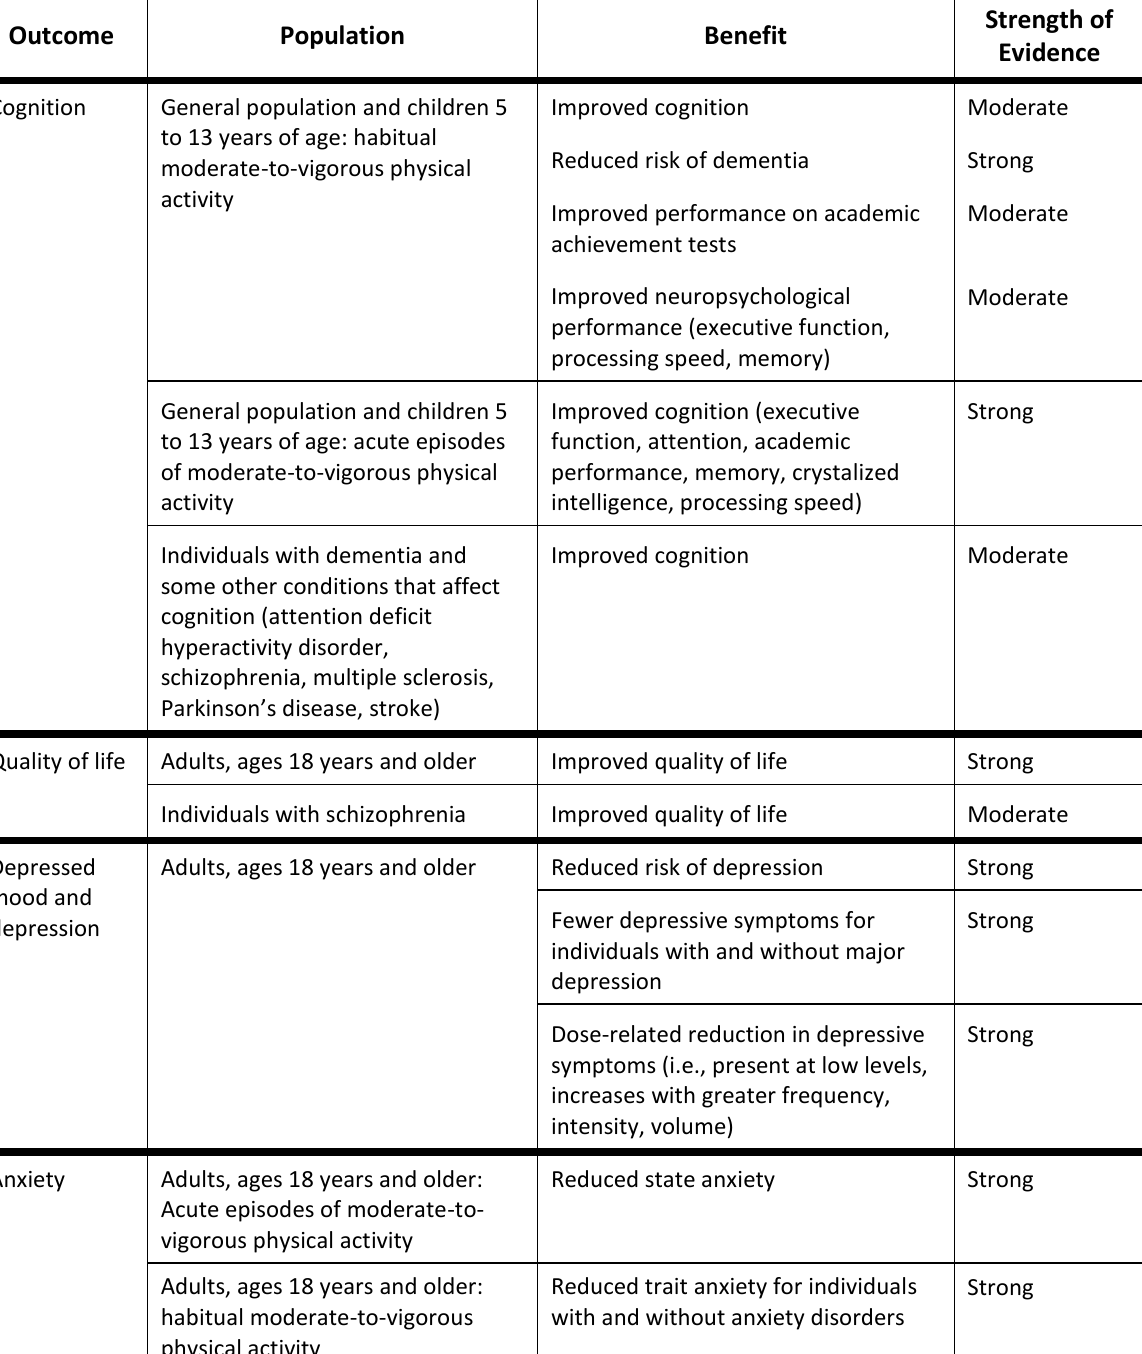
Table D-2. Summary of Conclusion Statements Regarding Strength* of the Evidence for Relationships Between Physical Activity and Cognition, Depression, Anxiety, Affect, Quality of Life, and